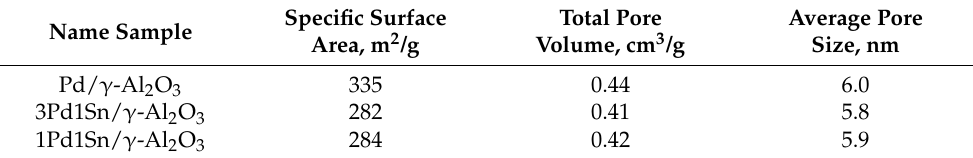
Table 4. Specific surface area, total pore volume and average pore size for